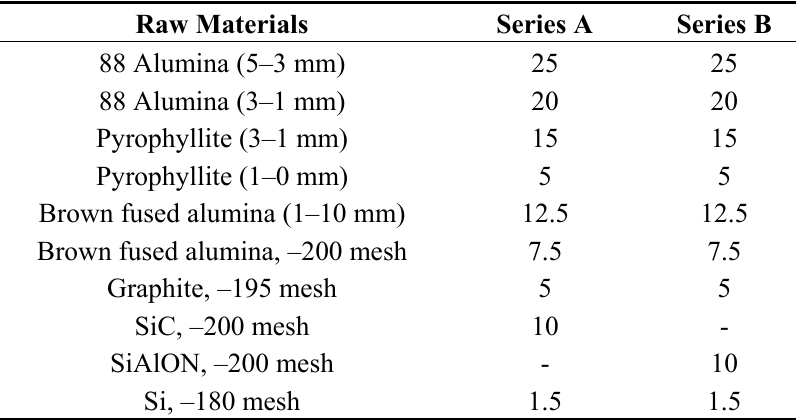
Figure 6. The photos of the iron ladle bricks with ( a ) SiC addition; ( b ) SiAlON addition. Table 4. Chemical compositions of iron ladle brick.